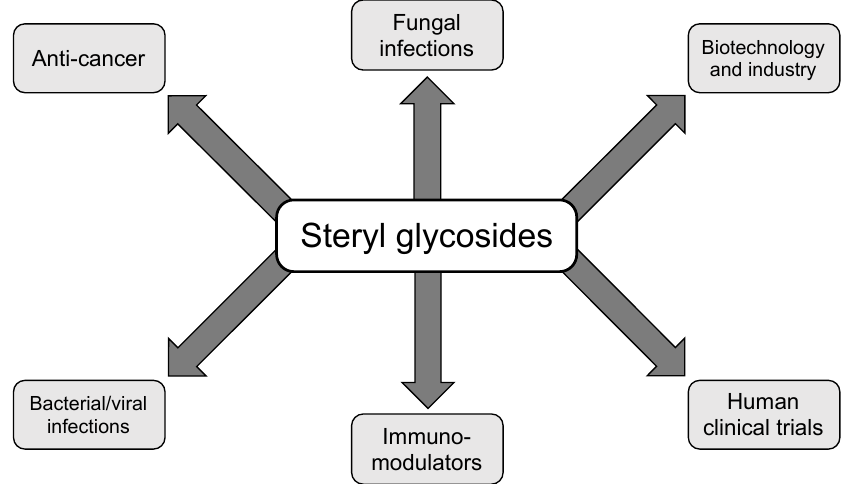
Figure 2. Multifaceted functions of SGs reported in the literature. Steryl glycosides have been implicated in several di ff erent aspects of biology including fungal, bacterial, and viral infections, anti-cancer treatments, immunomodulatory adjuvants, human clinical trial candidate compounds, and in the biotechnology and drug delivery system sectors. This figure is not a full representation of all uses of SGs in the literature as agricultural uses and crystallography studies have been reported, however, the graphic does pertain to the studies relevant to this